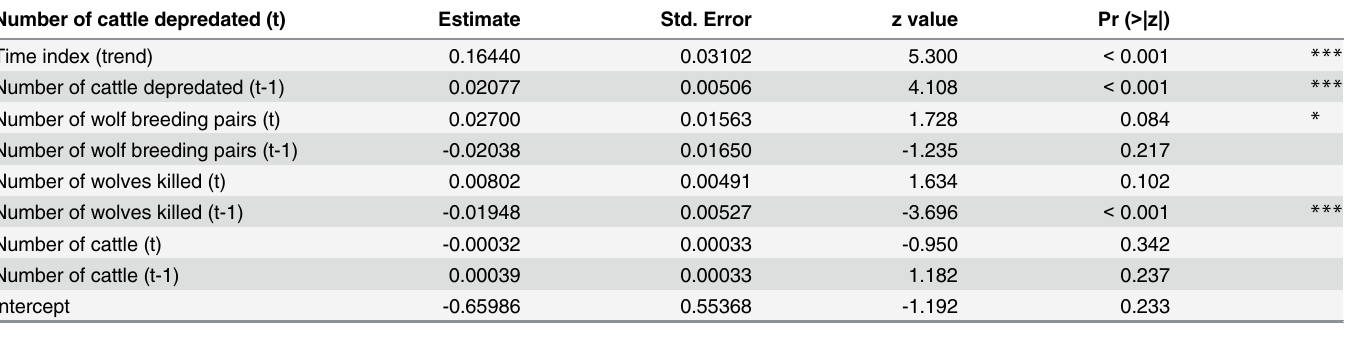
Table 1. Number of cattle depredated regressed on the number of wolves killed, number of wolf breeding pairs, number of cattle and time index. Number of cattle depredated (t)